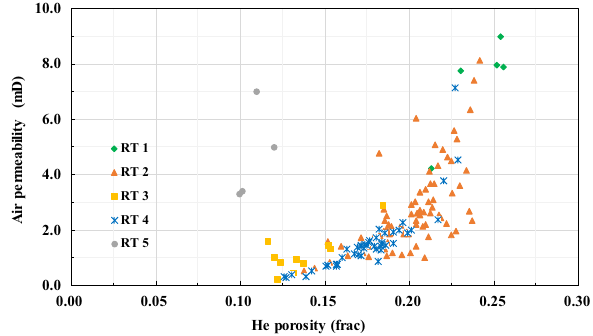
Fig. 8 Capillary pressure for the five RTs